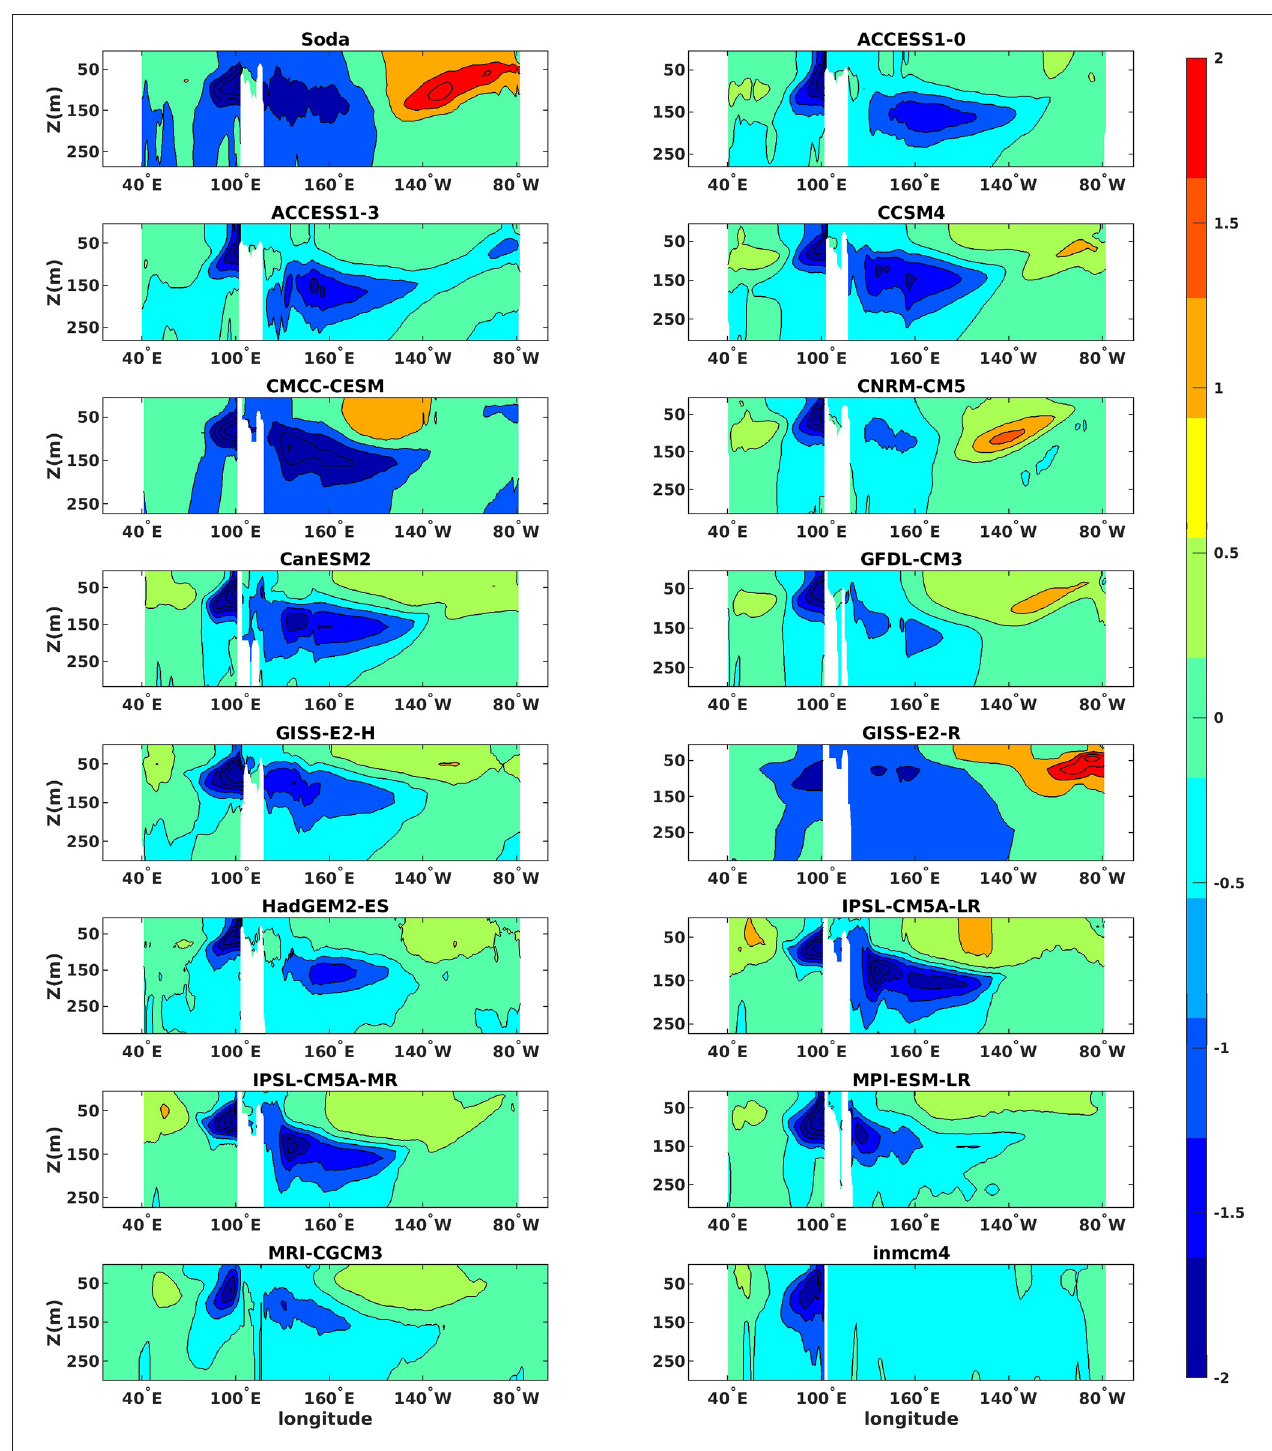
FIGURE 12 | Regression maps of the tropical Indo-Pacific sea subsurface temperatures averaged between 5 ◦ N and 5 ◦ S onto the IOD during the extended boreal fall season (ASON) of 1967–2005 for models and 1980–2018 for SODA reanalysis.